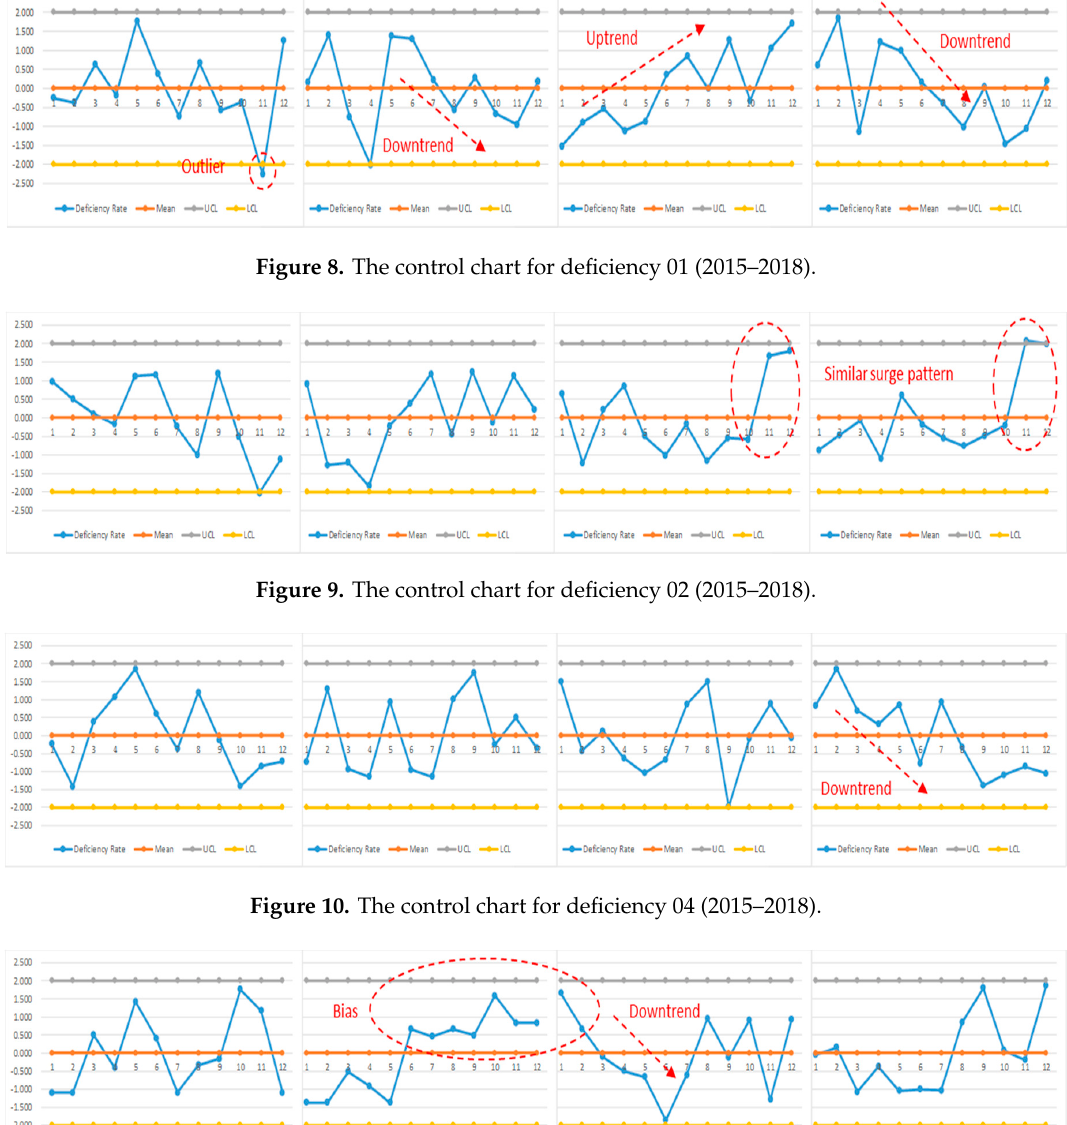
Figure 12. The control chart for deficiency 08 (2015–2018).